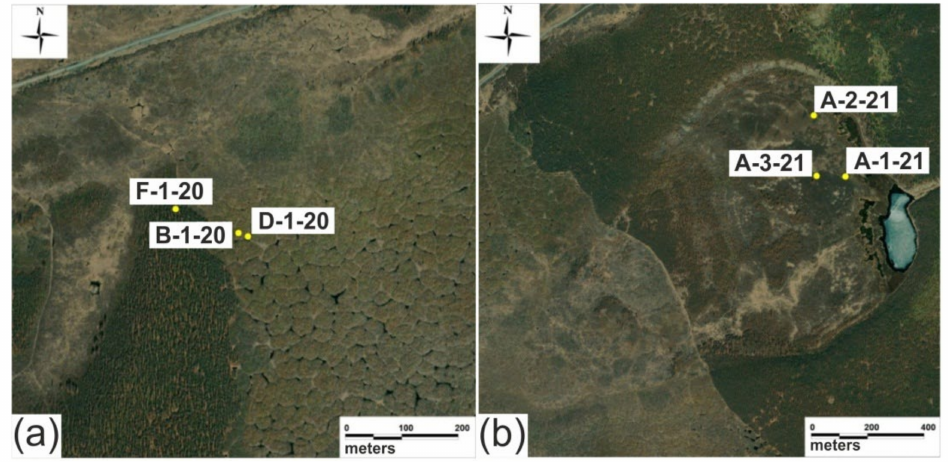
Figure 3. The scheme of soil profiles location on the study sites: ( a )—site No.1, ( b )—site